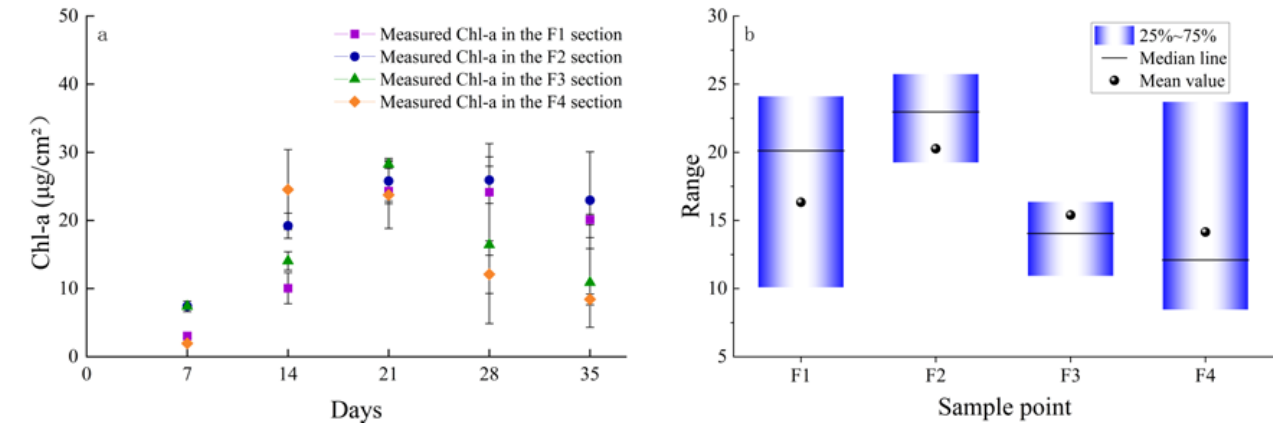
Figure 2. Evolution of the Chl-a ± SE ( µ g/cm 2 ) in the four flow velocity gradient sections (F1, F2, F3, and F4) on different days ( a ) and total average ( b ) after the experimental operation.